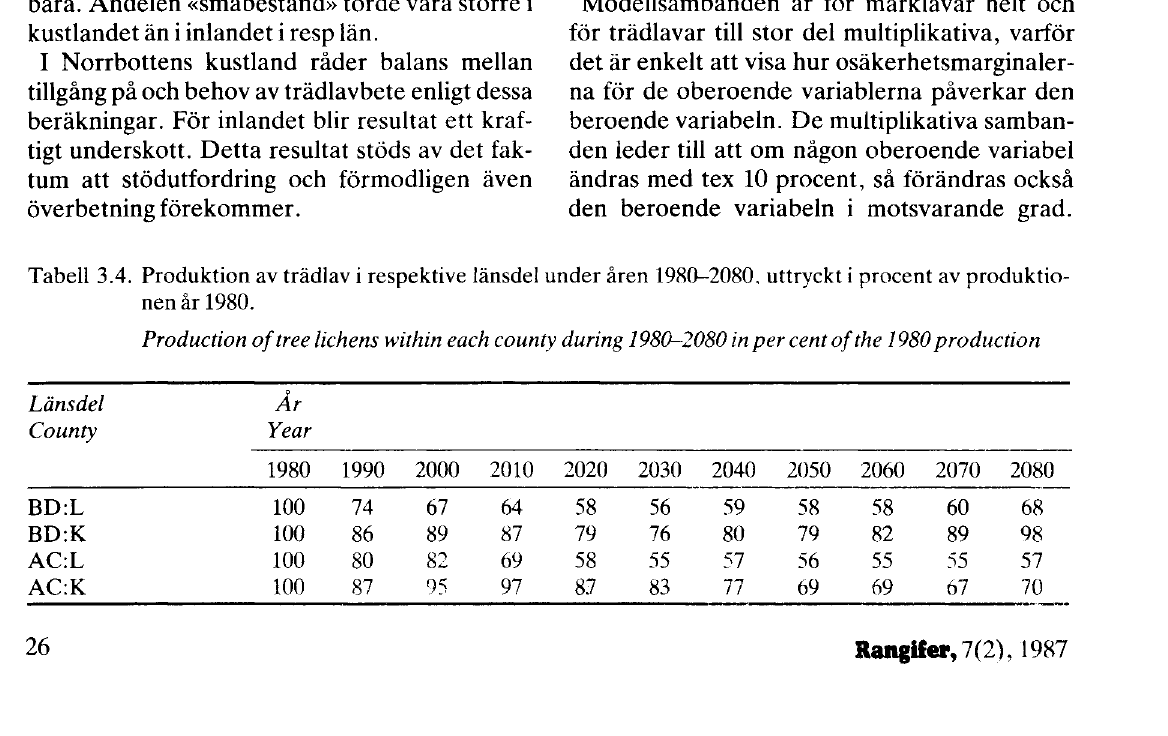
Tabell 3.4. Produktion av trådlav i respektive lånsdel under åren 1980-2080, uttryckt i procent av produktio nen år